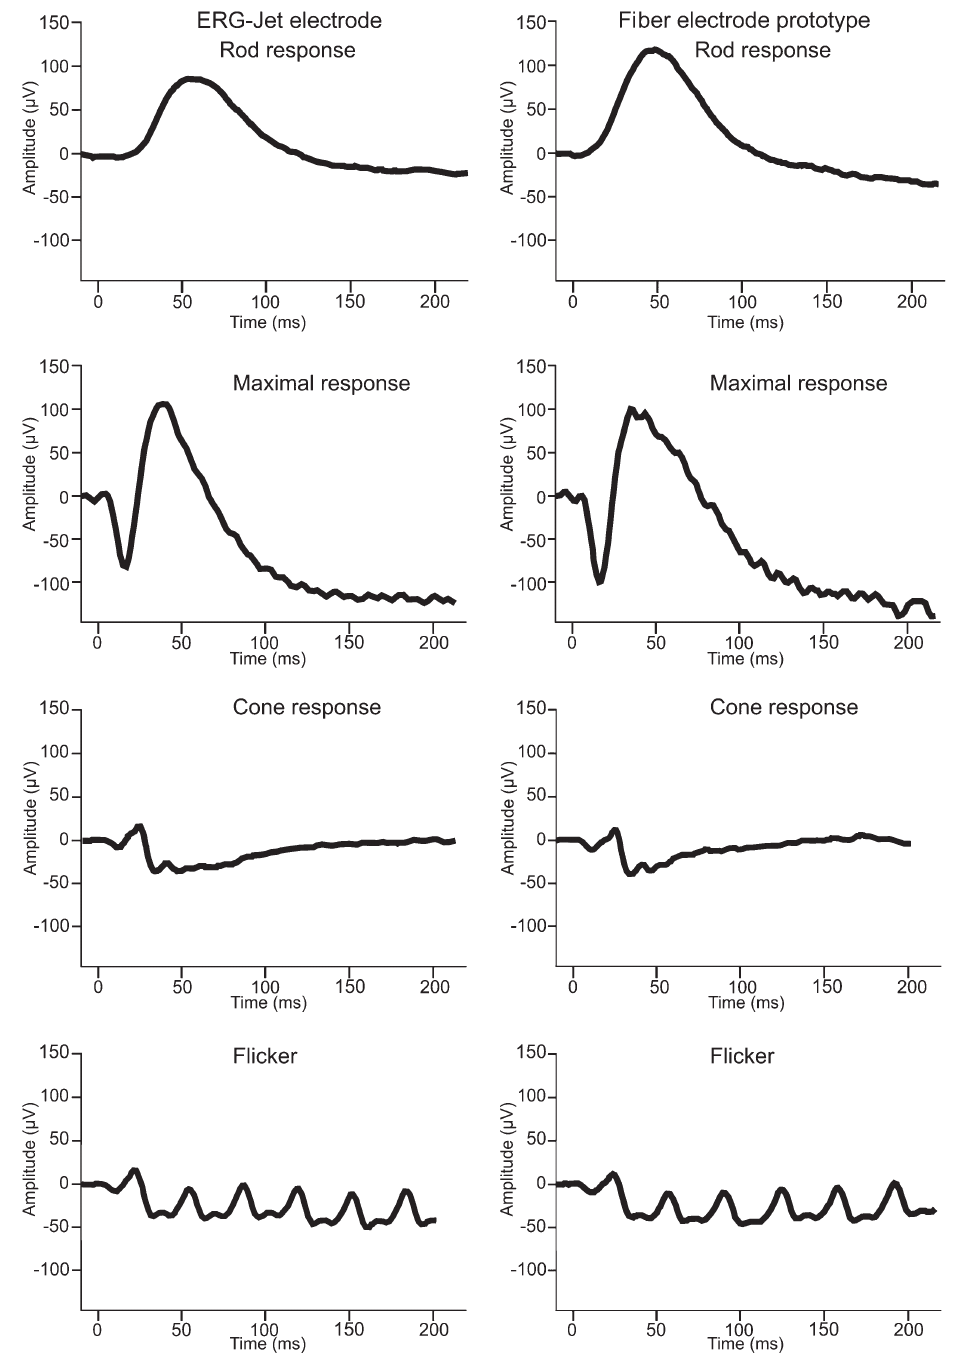
Figure 2. Representative electroretinogram (ERG) responses of a healthy Yorkshire terrier dog. Left panels , ERG recordings obtained with the ERG-Jet lens electrode. Right panels , ERG recorded with the fiber electrode implicit times of the healthy Yorkshire terrier group studied using the ERG-Jet lens electrode and the fiber electrode prototype are shown in Figure 3.